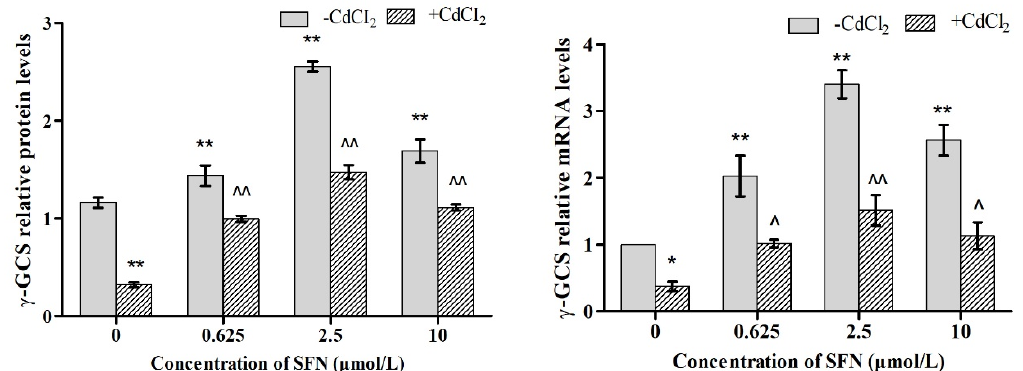
Figure 10. Effects of SFN on Cd induced the relative mRNA and protein expression of γ‐ GCS of the TM4 cells. * p < 0.05 as compared to the control group, ** p < 0.01 as compared to the control group, ^ p < 0.05 as compared to the Cd group, ^^ p < 0.01 as compared to the Cd group.